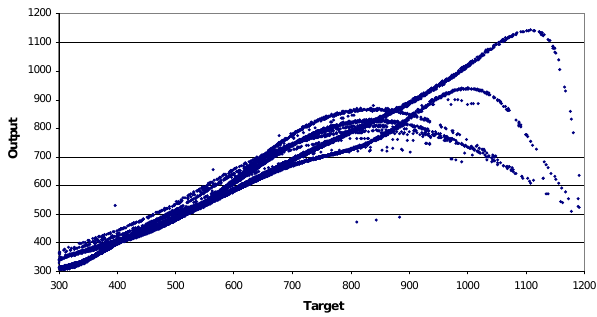
Fig. 4. Results of NN forecasts: outputs ( E ret predictions) vs. targets ( E ret real values) on the test set.